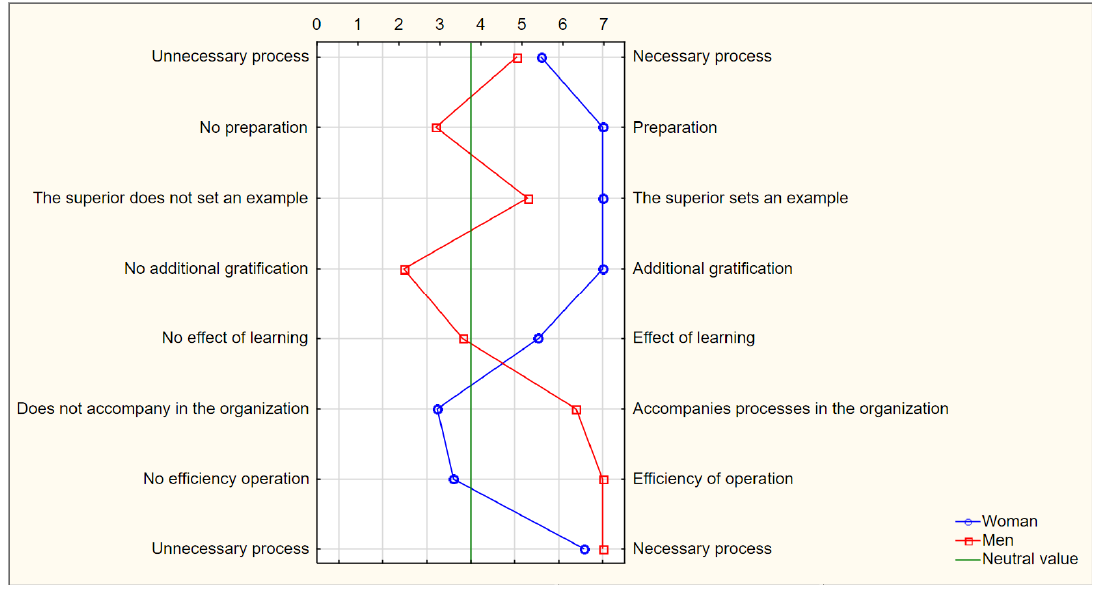
Figure 4. Knowledge sharing according to respondents (men and woman).